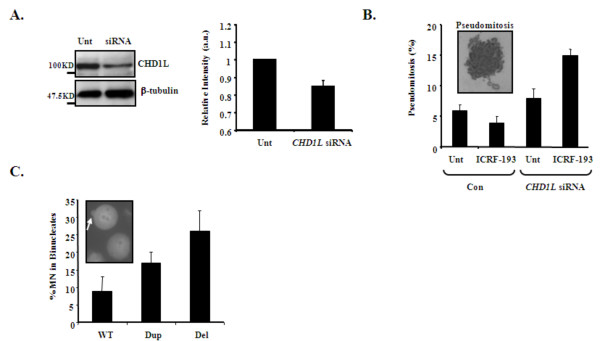
Consequences of limiting CHD1L levels by siRNA. (A). Careful titration of CHD1L siRNA conditions were undertaken in A549 so as to mimic haploinsufficient expression of CHD1L. Left panels:These show the Western analysis of whole cell extracts from Untreated (Unt; mock-treated) control whereas siRNA indicates cells treated with CHD1L siRNA. β-tubulin expression was monitored to confirm equal loading. Right graph: Densiometric quantification of CHD1L expression, normalized to β-tubulin loading from three separate siRNA experiments. The degree of CHD1L reduction is very similar to that observed from the 1q21.1 deletion (Del) containing LBC (Fig 3A and B). Data represents the mean ± s.d. of three separate experiments (a.u. arbitrary units). (B). Inset image shows a typical catenated pseudomitotic cell following CHD1L siRNA-mediated knockdown in A549 treated with Topo II inhibitor (ICRF-193). The % pseudomitosis were enumerated under various conditions in A549 following CHD1L siRNA-mediated knockdown to mimic haploinsufficiency. Unt (untreated; not treated with ICRF-193), ICRF-193 (treated with ICRF-193), Con (control siRNA scrambled oligo), CHD1L siRNA (treated with siRNA to mimic CHD1L haploinsufficiency). Data represents the mean ± s.d. of three separate experiments and p < 0.005 for increase in Pseudomitosis (%) following CHD1L siRNA. (C). Inset image shows micronuclei (MN). The % of ICRF-193-induced MN in binucleate cells were determined in wild type (WT), Dup and Del containing LBLs following a 24 hr recovery from an overnight treatment with ICRF-193. Data represents the mean ± s.d. of three separate experiments and p = 0.02 for increase % MN in binucleates for Dup and p < 0.005 for Del containing LBCs.